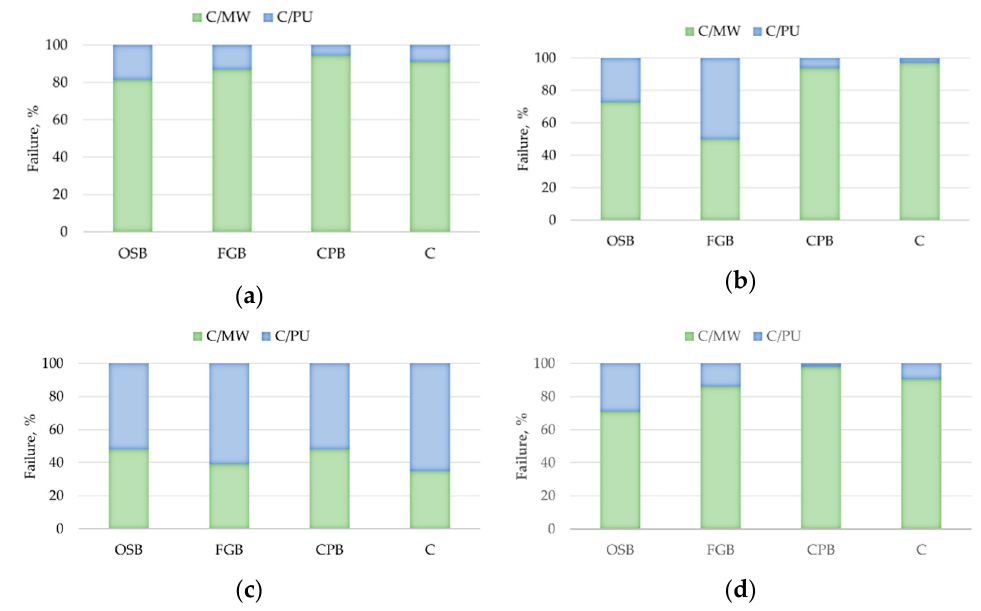
Figure 8. Model of damage—average values for the series: ( a ) 23/50/8, ( b ) 25/30/8, ( c ) 25/90/8 and ( d ) 5/-/8 (C/MW—cohesive damage within the MW, C/PU—cohesive damage within the PU adhe- sive).